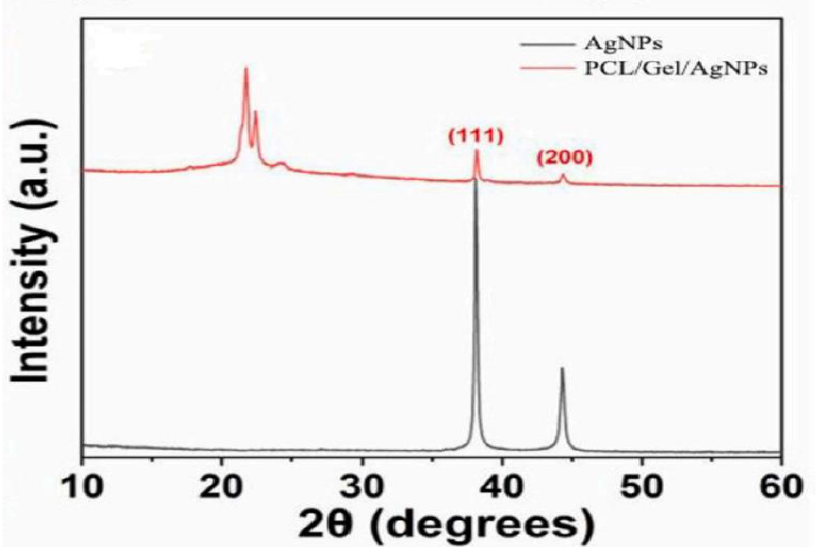
Figure 11. XRD patterns of AgNPs and PCL/Gel-AgNPs. Images reproduced with permission from [168] © 2021 Materials Science & Engineering C. Published by Elsevier Ltd. (Amsterdam, The Neth- erlands).